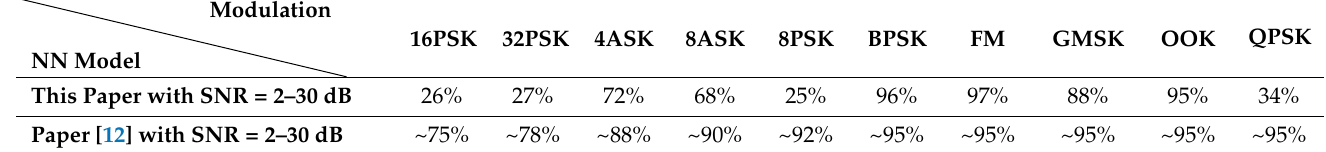
Table 7. Comparison of cloud-based neural networks and local neural networks